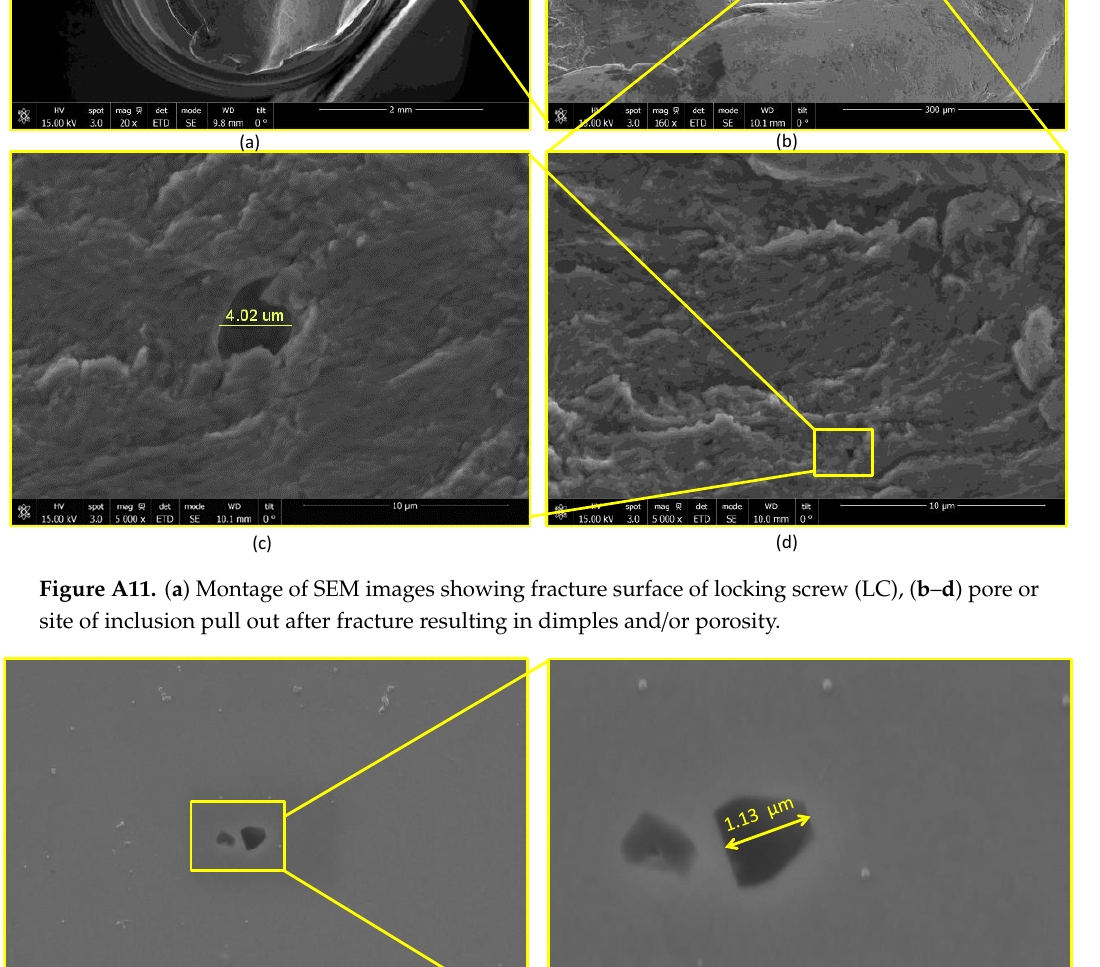
Figure A12. Evidence of Si-based inclusions, these inclusions have sharp points and could be crack initiators.